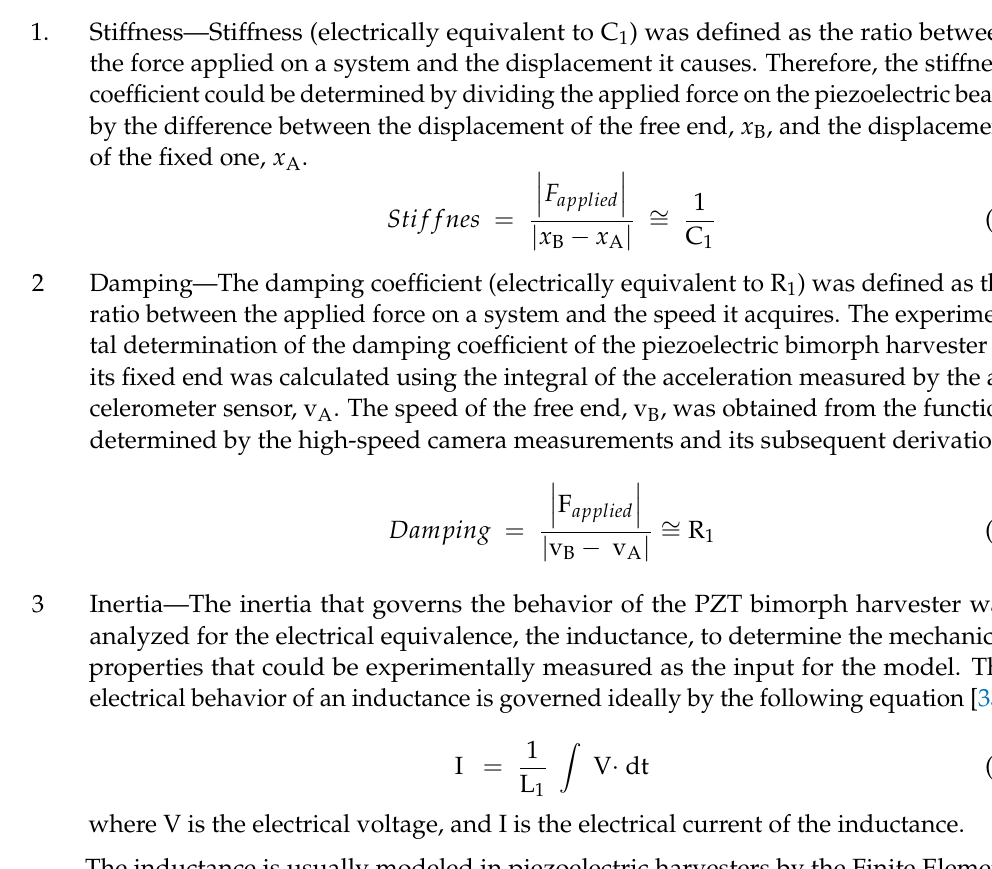
of the fixed one, x A